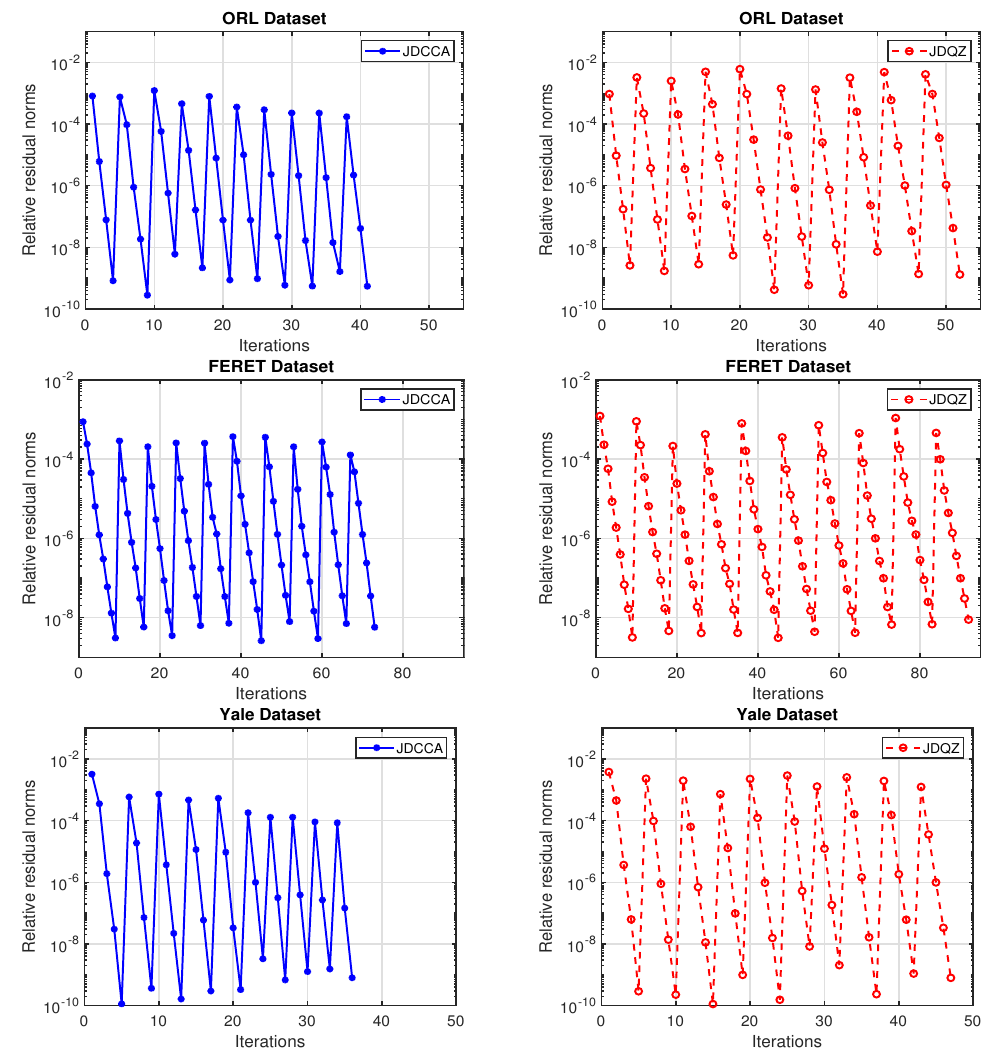
Figure 3. Convergence behavior of JDCCA and JDQZ for computation of the first 10 canonical weight vectors of ORL ( top ), FERET ( middle ) and Yale ( bottom ) datasets with MINRES step n g =